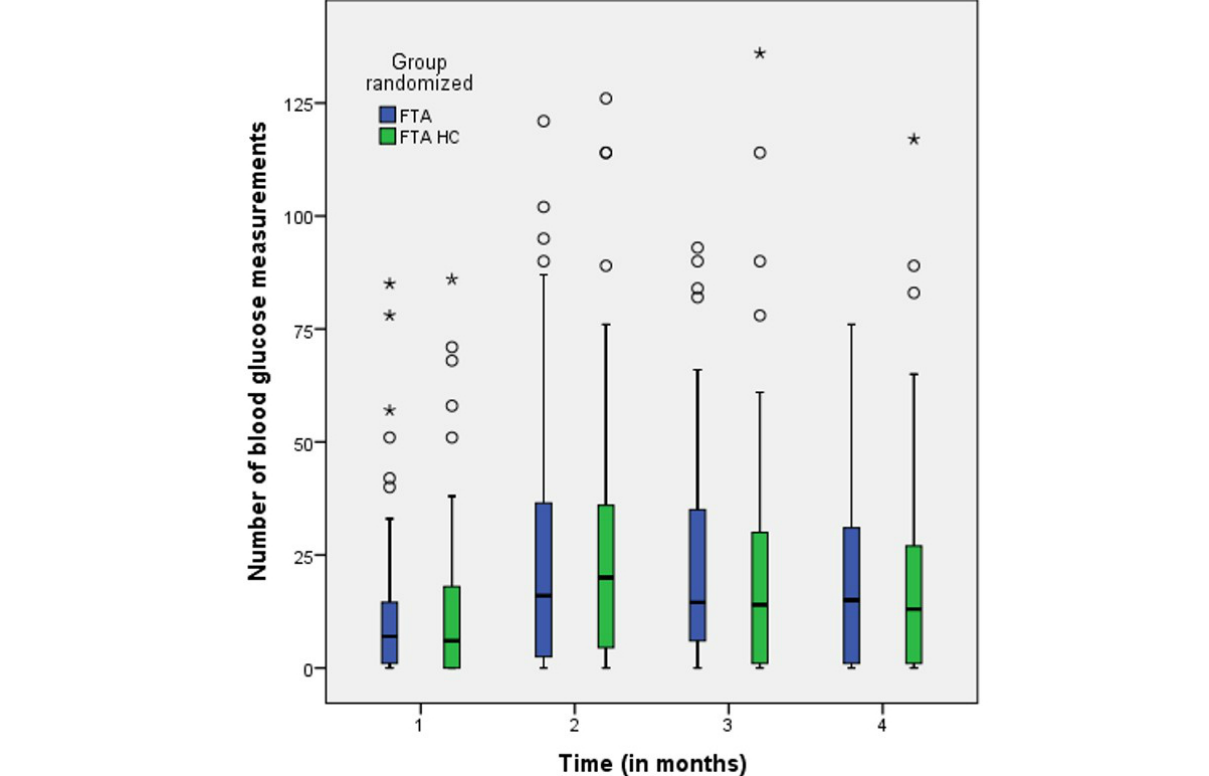
Figure 2. Number of blood glucose measurements during the first 4 months for the 2 intervention groups: Few Touch Application (FTA) and FTA with health counseling (HC). Time 1 (baseline): n=90; time 2: n=83; time 3: n=80; and time 4: n=79.